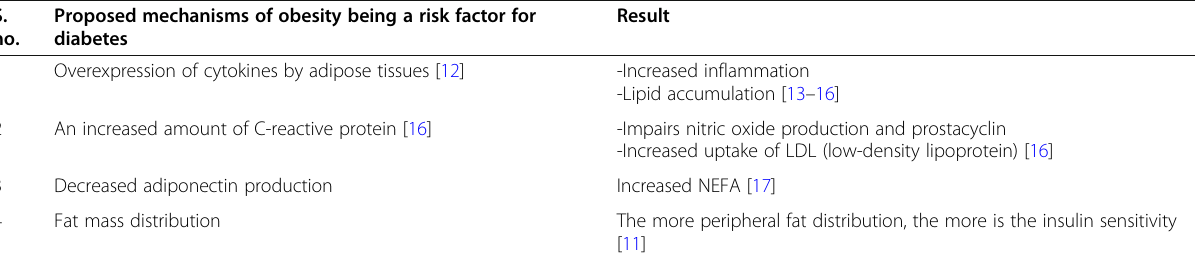
Table 1 Obesity as a factor of risk for diabetes S. no.